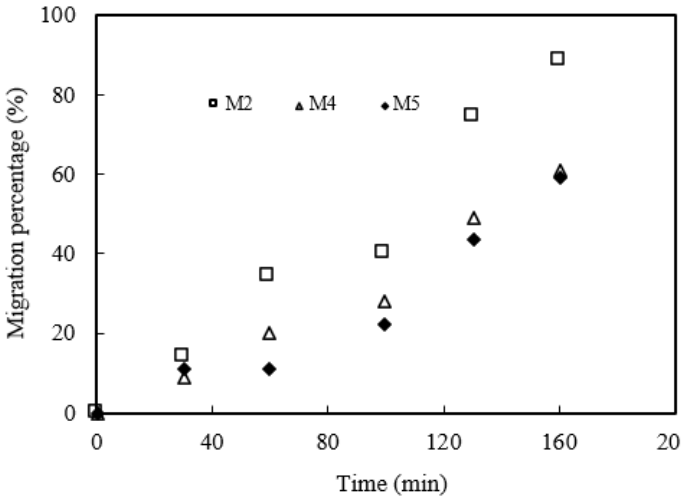
Figure 17. Effect of microtubule internal diameter.